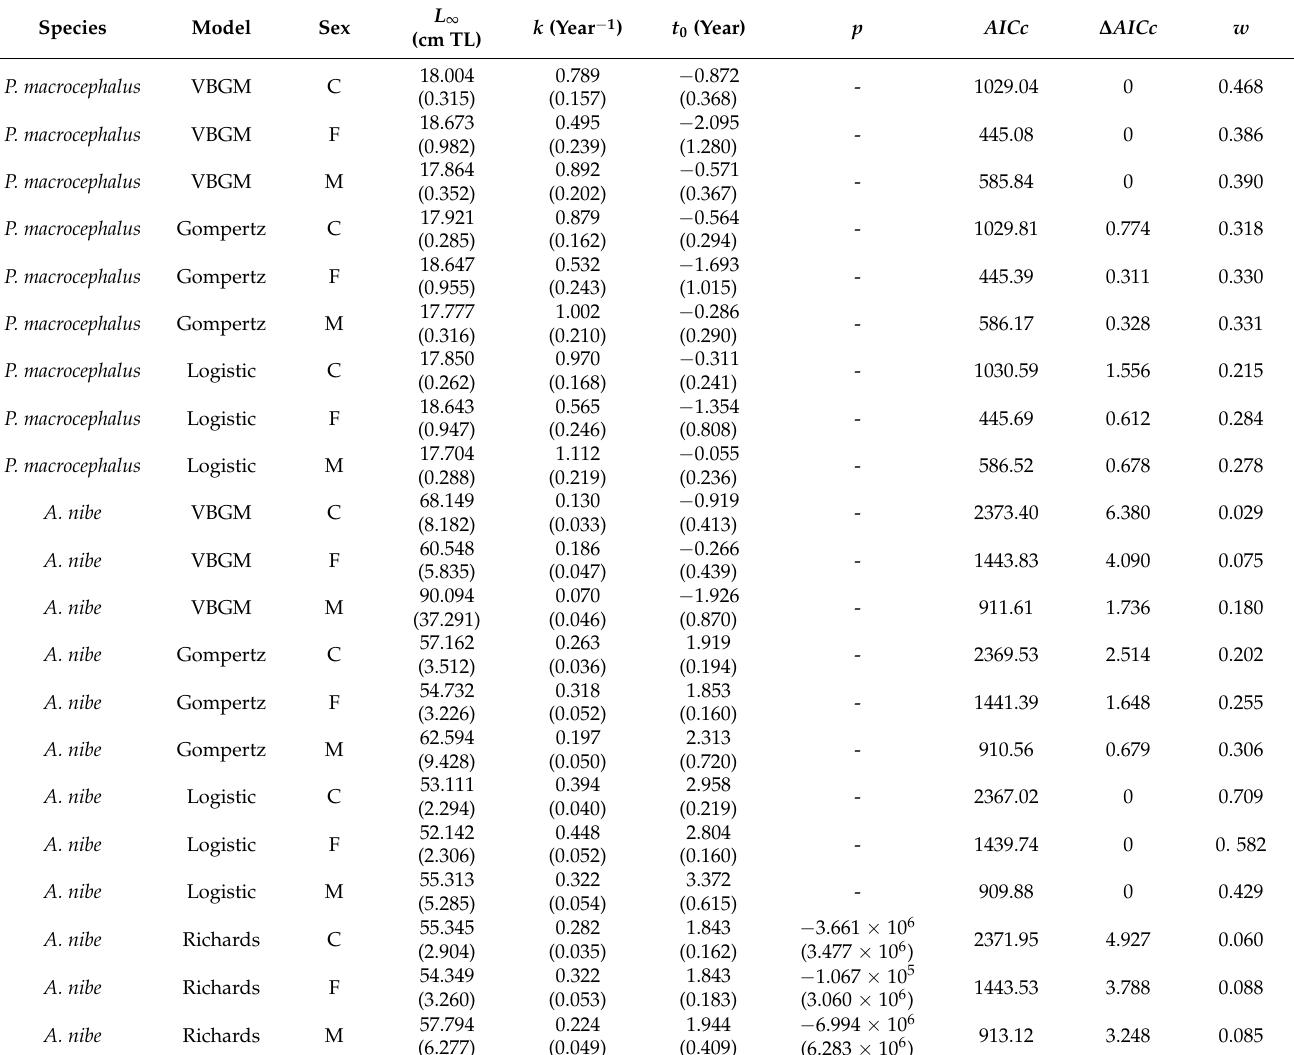
Table 2. Parameter estimates ( ± standard error) from four candidate growth models, by sex, for P. macrocephalus and A. nibe off Southwestern Taiwan. The best-fit models are shown in